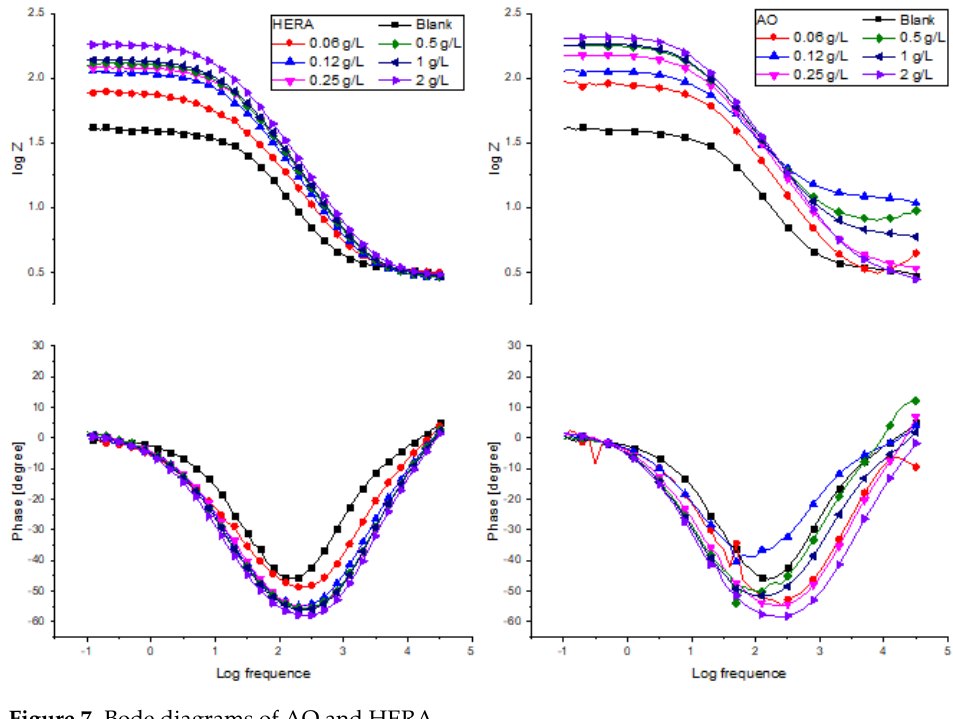
Figure 7. Bode diagrams of AO and HERA.